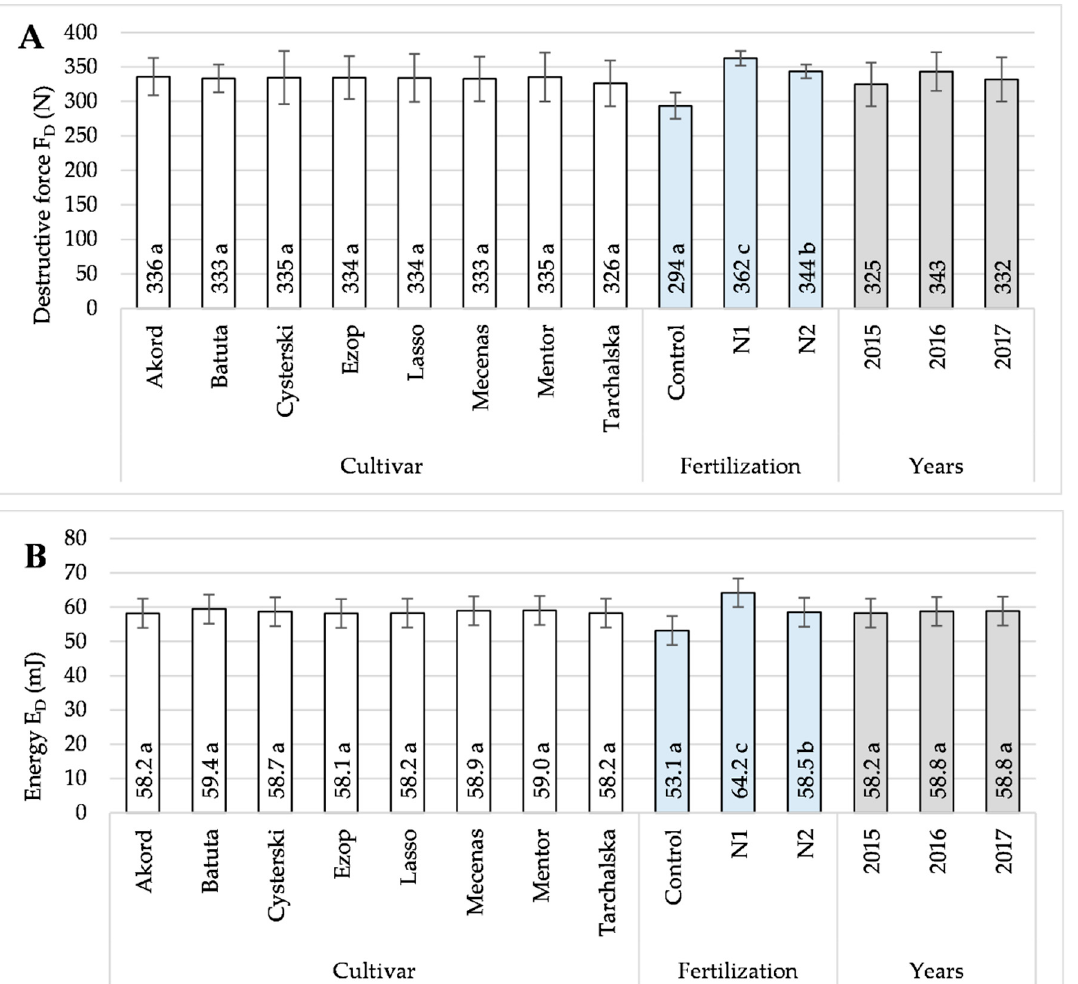
Figure 2. Average values of mechanical parameters depending on the cultivar, fertilizer treatment, and year of research: ( A )—Destructive force F D (N), ( B )—destructive energy E D (mJ), and ( C )—relative deformation D R (%). Statistical analysis was carried out separately for each factor (cultivar, fertilization, and year). Means followed by different letters show sig- nificant differences ( p < 0.05) according to the Tukey test. The differences are marked with letters a–c. The fertilizers applied modified the chemical composition of pea seeds (Table 3). Compared to the control, the N1 fertilizer treatment significantly increased the protein, fat and ash content, and reduced the NFE content in the seeds, while the N2 fertilizer treatment only increased the protein content. The fertilizer treatment also had an effect on the content of micro- and macronutrients in the material analyzed. The seeds obtained from plants fertilized with treatment N1 contained the most K, with the least K after the N2 fertilizer treatment. The use of both variants of fertilizer treatment (N1 and N2) re- sulted in a significant reduction in the amount of Fe, Zn, and Cu in seeds, but it had no significant effect on the content of P, Ca, Mg, Na, and Mn. Table 3. Chemical composition of pea seeds depending on foliar fertilization. Nutrients Fertilization Control